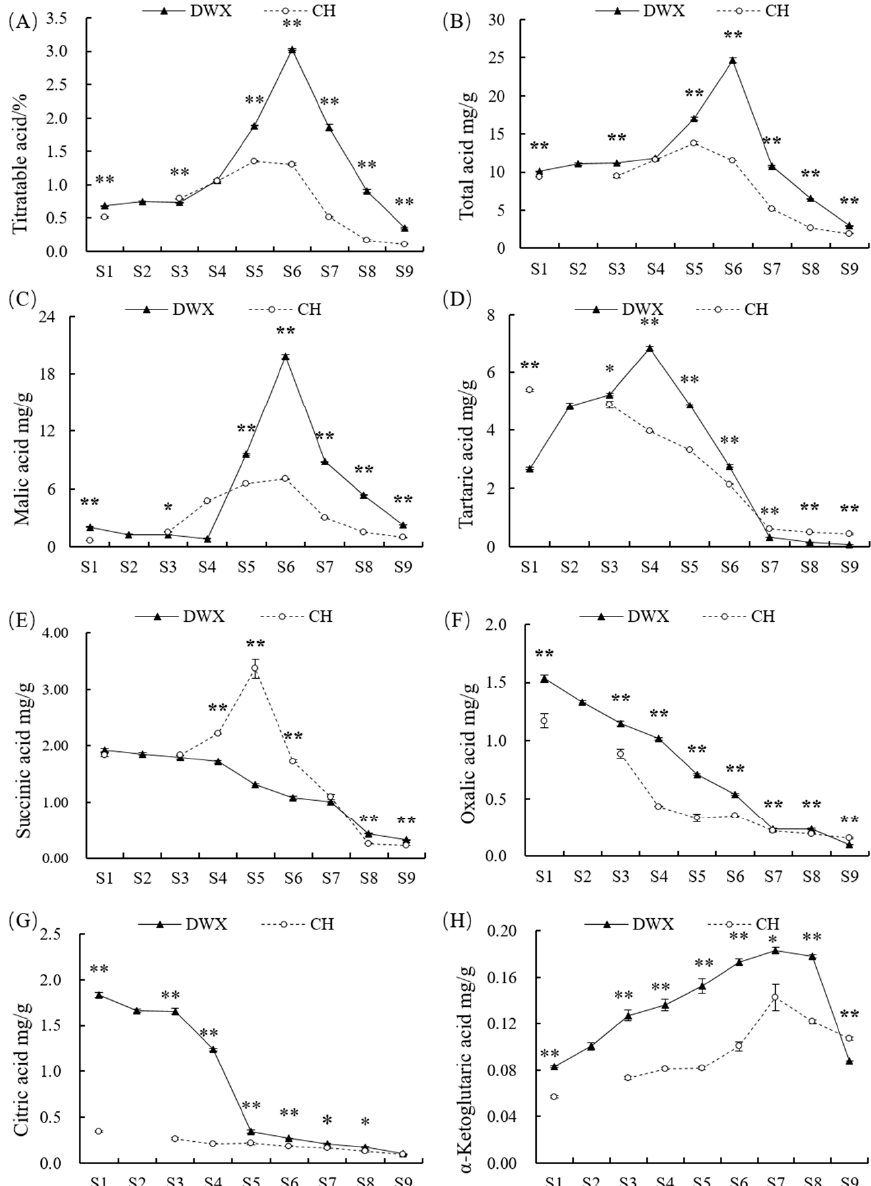
Figure 3. Dynamic changes of titratable acid ( A ), total acid ( B ), malic acid ( C ), tartaric acid ( D ), succinic acid ( E ), oxalic acid ( F ), citric acid ( G ), and α -ketoglutaric acid ( H ) contents at different stages during fruit development and ripening of Dawuxing and Chunhua loquats. The stages on the x-axis corresponded to those presented in Figure 1. The asterisks in the line charts indicate significant differences (*: p ≤ 0.05; **: p ≤ 0.01).